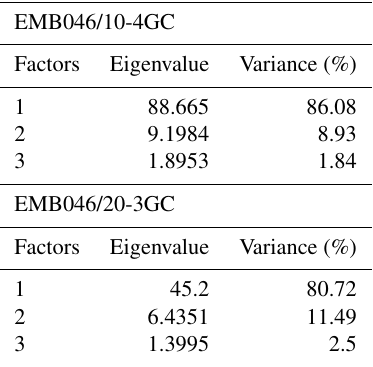
Table 3. The factor results from a CAB-FAC factor